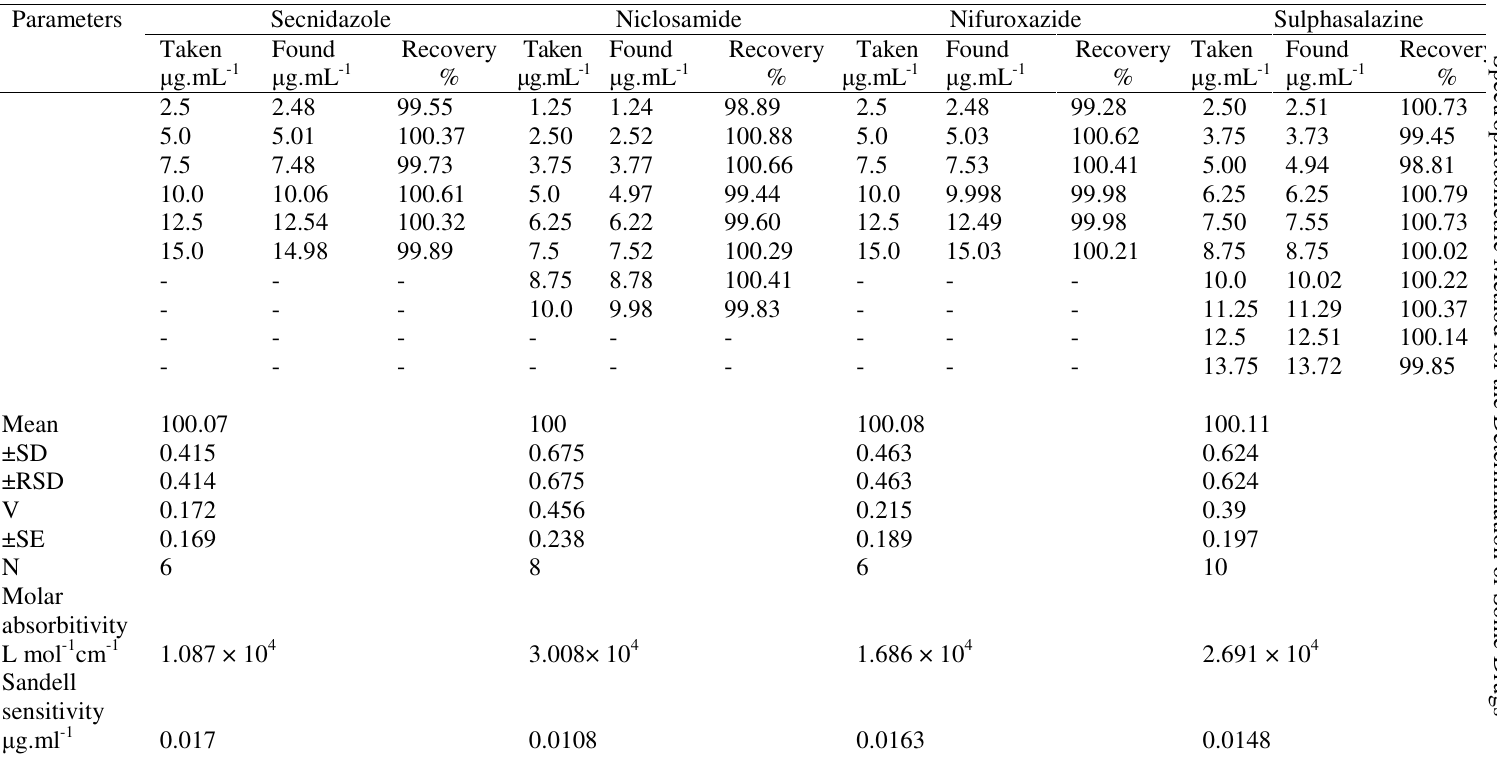
Table 2 . Results of the analysis for determination of the cited drugs using fast red B salt